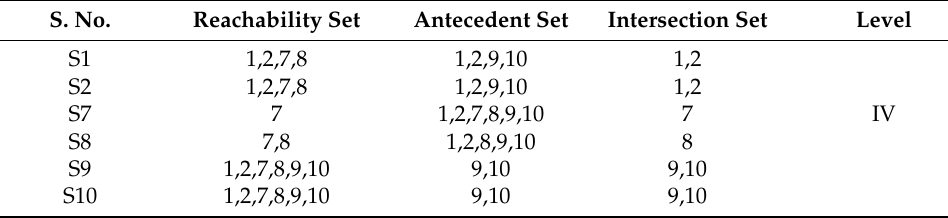
Table A4. Level partitions (Iteration IV). S. No.